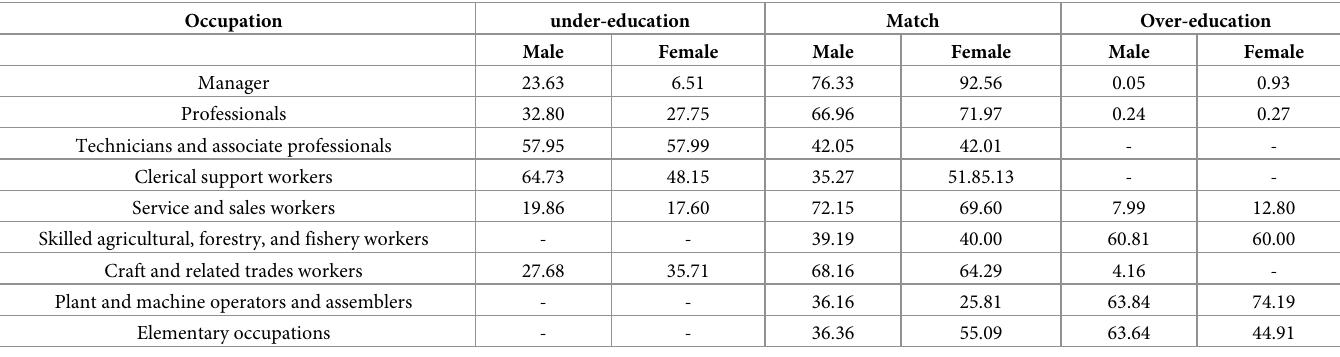
Table 4. Percentage distribution of mismatch by